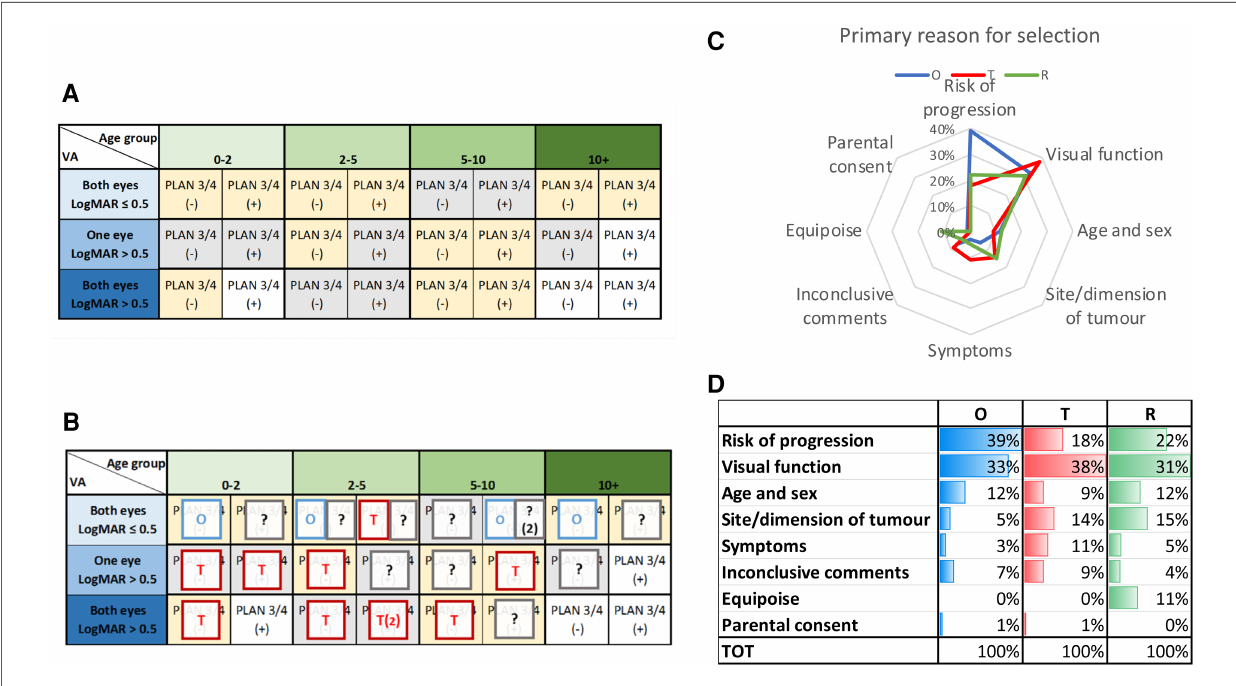
FIGURE 4 ( A ) A matrix of patient characteristics including visual acuity (LogMAR scores for one/both eyes), PLAN stage ¾ +/ − (optic radation involvement) and age at diagnosis, ( B ): consensus (>70%) voting for 25 NF1 OPHG patient histories reported within the matrix identifying cases selected for initial observation ( O ), treatment ( T ) or? randomisation (?). ( C ) Spider plot of primary reason for consensus judgement for O,T & R. ( D ) Table of clinical reasons supporting strategy selection for O,T & R